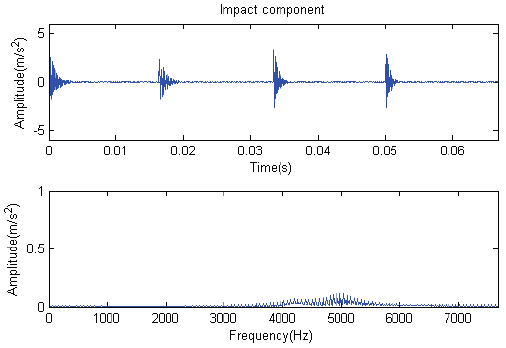
Figure 22. Impact component.